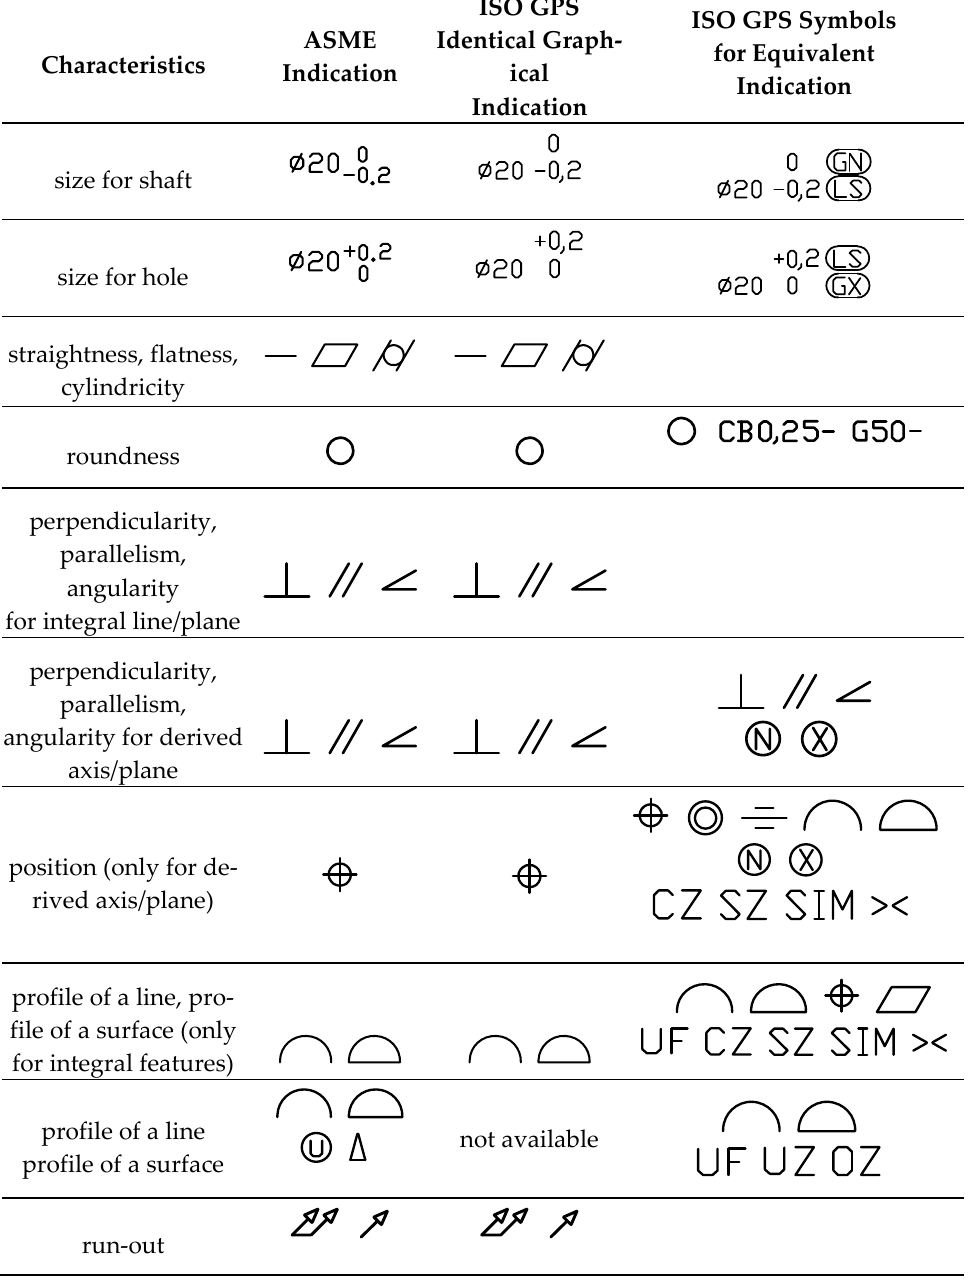
Table 1. Comparison of ASME Y14.5 and the ISO GPS system symbols meaning.